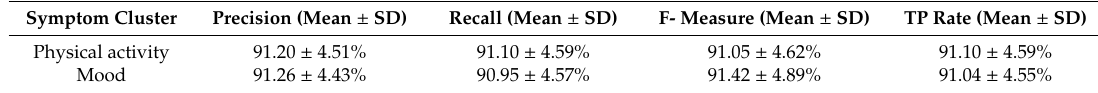
Table 4. Physical activity and mood level classification results.